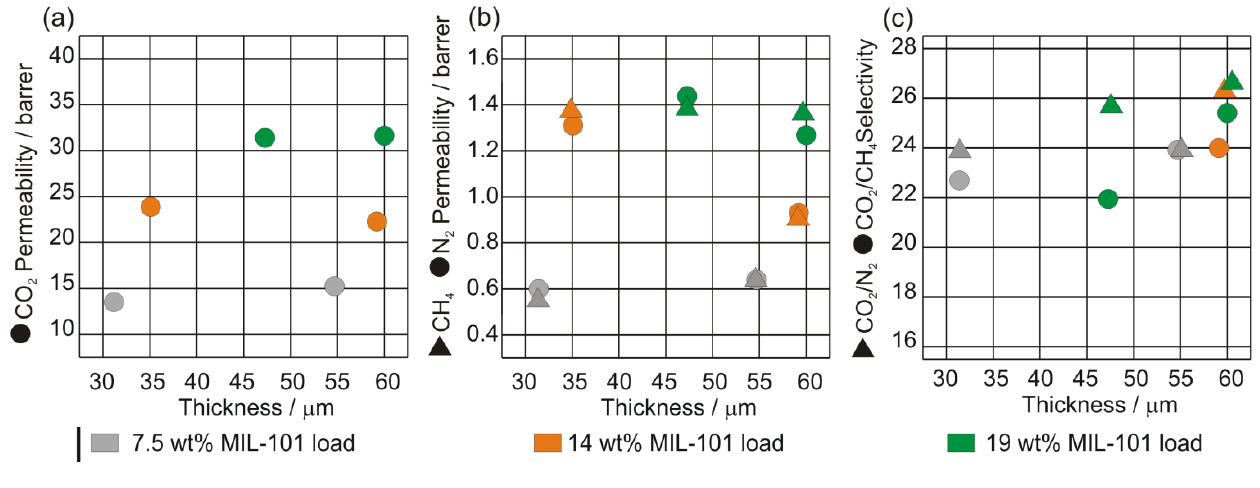
Figure 15. ( a ) Single-gas CO CO /N selectivities for MIL-101/PSF membranes at different MIL wt.% loadings and 2 2 membrane